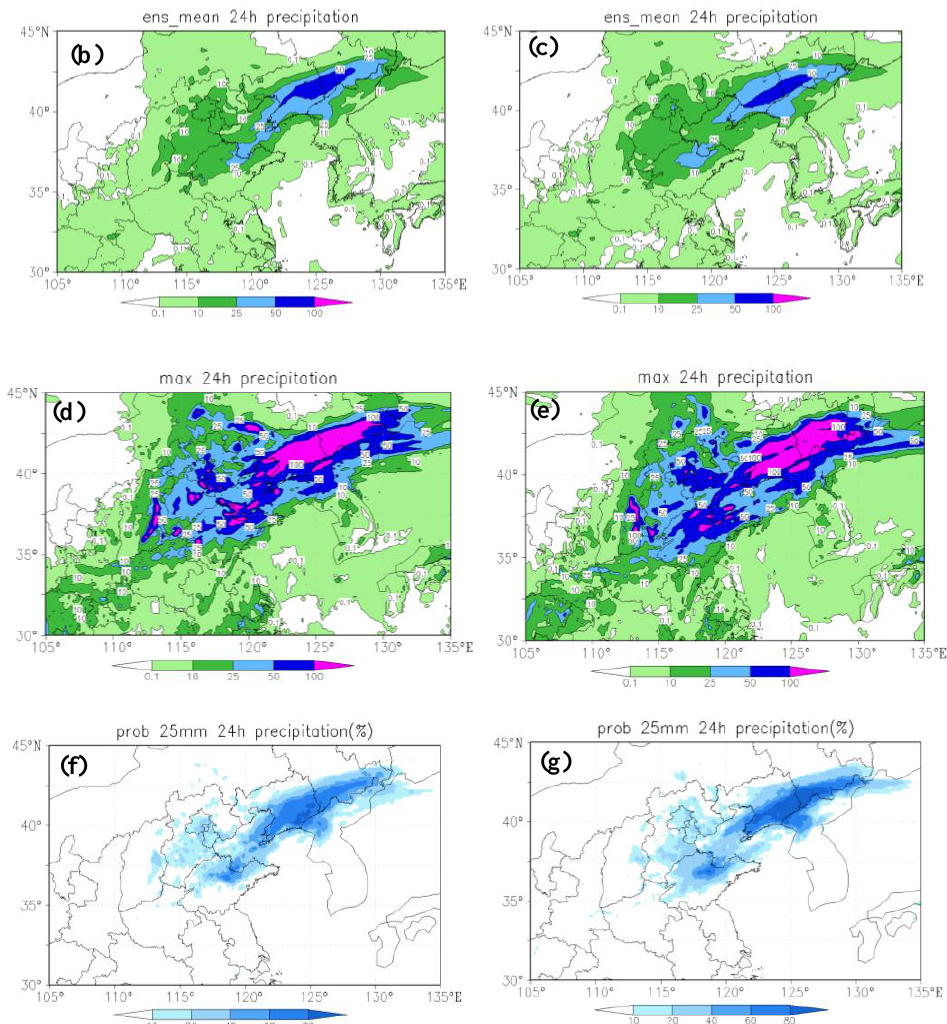
Figure 10. The verification of precipitation. ( a ) 24-h cumulative precipitation of the observation from 00 UTC 30 July 2015 to 00 UTC 31 July 2015; ( b , c ), 24-h cumulative precipitation ensemble average forecast of the ETKF and ETKF-SS; ( d , e ), the maximum precipitation forecast of the ETKF and ETKF-SS; ( f , g ), the probability prediction of precipitation greater than 25 mm for the ETKF and ETKF-SS.